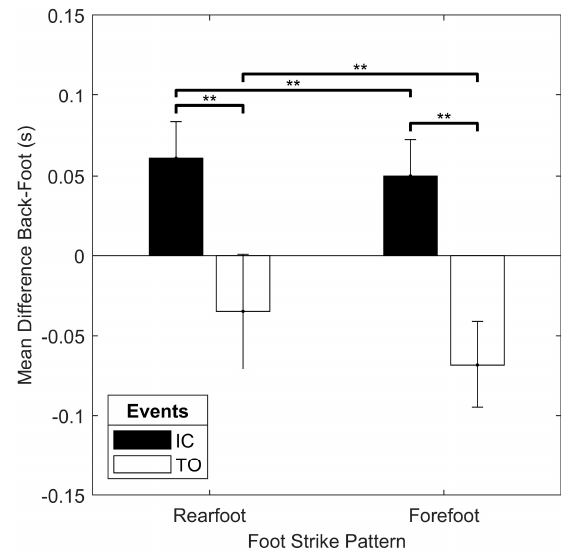
Figure 8. Results of the foot strike x event interaction on the mean difference between the back and foot algorithms for the indoor track running conditions. ** simple main effect significant at p < 0.01.